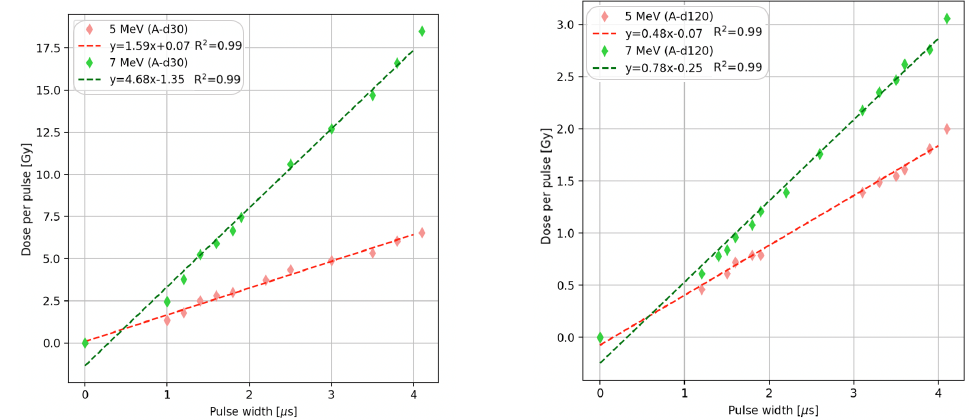
Figure 5. Dose per pulse measurements with film at the end of the A-d30 ( left ) and A-d120 ( right ), for 5 MeV electron beam (red) and 7 MeV (green), as a function of the pulse width. The dashed lines show the linear fit.